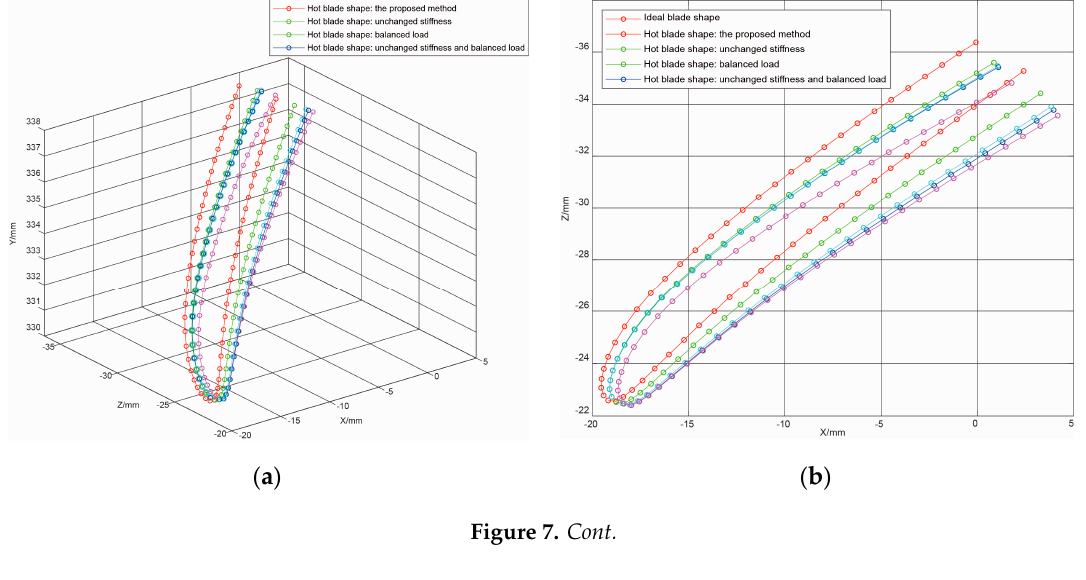
Figure 6. Coordinate changes of the contour node at the blade top.